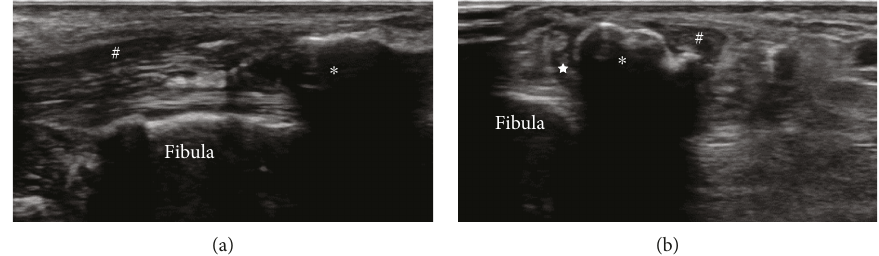
Figure 4: Ultrasonographic images showed an elliptical mass with an echoic shadow on the a ff ected side of the peroneal tendon sheath. (a) Longitudinal image and (b) transverse image. ∗ Heterotopic ossi fi cation. # Peroneus longus tendon. ★ Peroneus brevis tendon.